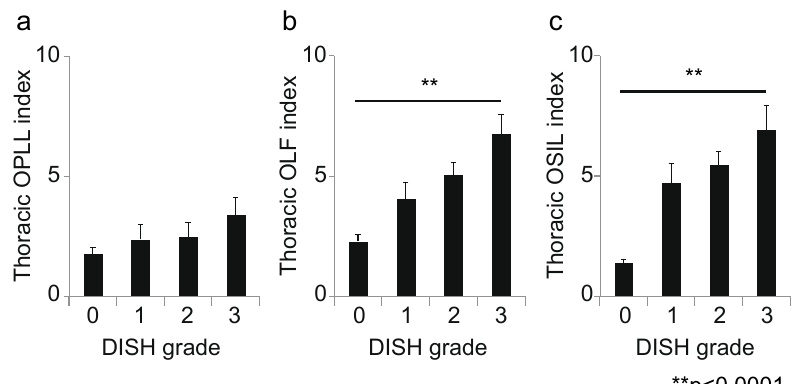
Figure 4. Correlation between DISH grade and OSL at the thoracic level. ( a ) Thoracic OPLL index; ( b ) thoracic OLF index; ( c ) thoracic OSIL index. DISH, diffuse idiopathic skeletal hyperostosis; OLF, ossification of the ligamentum flavum; OPLL, ossification of the posterior longitudinal ligament; OSIL, ossification of the supra/interspinous ligaments; OSL, ossification of the spinal ligaments.